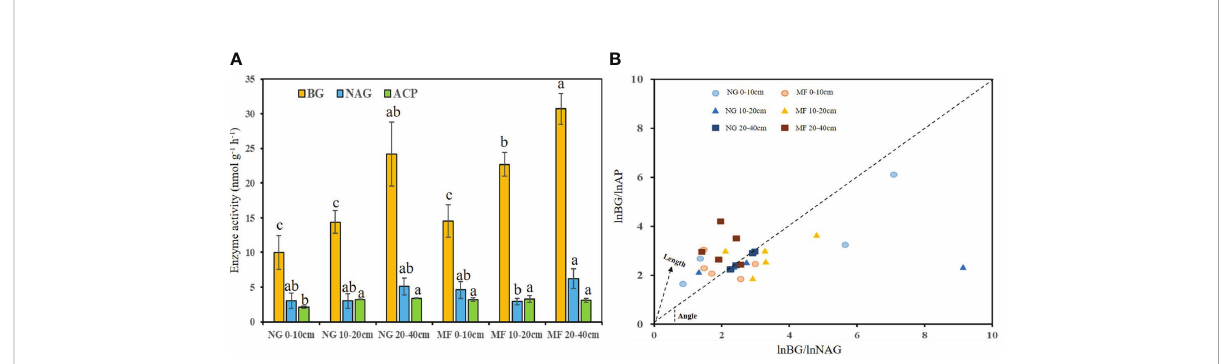
FIGURE 1 Enzyme activity (A) and enzyme stoichiometric constraints (B) of different soil layers (0 – 10 cm, 10 – 20 cm, and 20 – 40 cm) under different treatments (NG, natural grass; MF, planting ryegrass and mowing for feed). Changes of vector length (L) and vector angle (A ◦ ) were calculated according to the ratios of the log transformed BG, NAG, and AP (Moorhead et al. 2016). Longer vector L indicates greater C limitation. A vector angle of < 45 ◦ denotes N limitation, angles > 45 ◦ denote P limitation. Lowercase letters a, b and c indicate a signi fi cant difference (p < 0.05). BG,